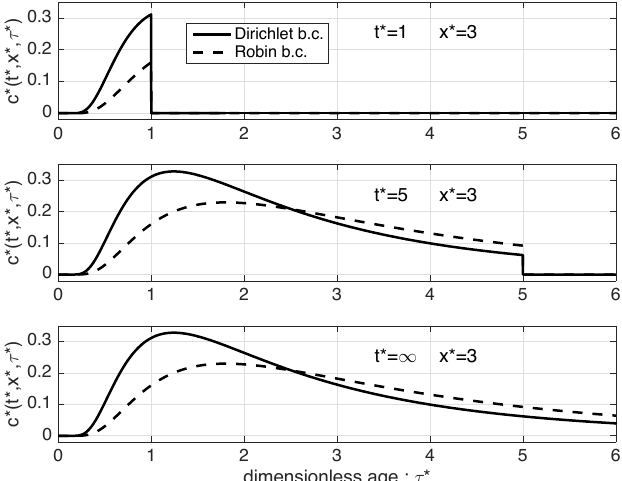
Figure 2. Schematic representation of a semi-infinite domain ( x ∈ [ 0, ∞ [ ) with a departure boundary at x = 0. On this boundary, we can either prescribe that all particles of the tracer under study have zero age (Dirichlet boundary condition) or that the age of the incoming particles is zero, which leads to a Robin boundary condition, as seen in Section 3.3.